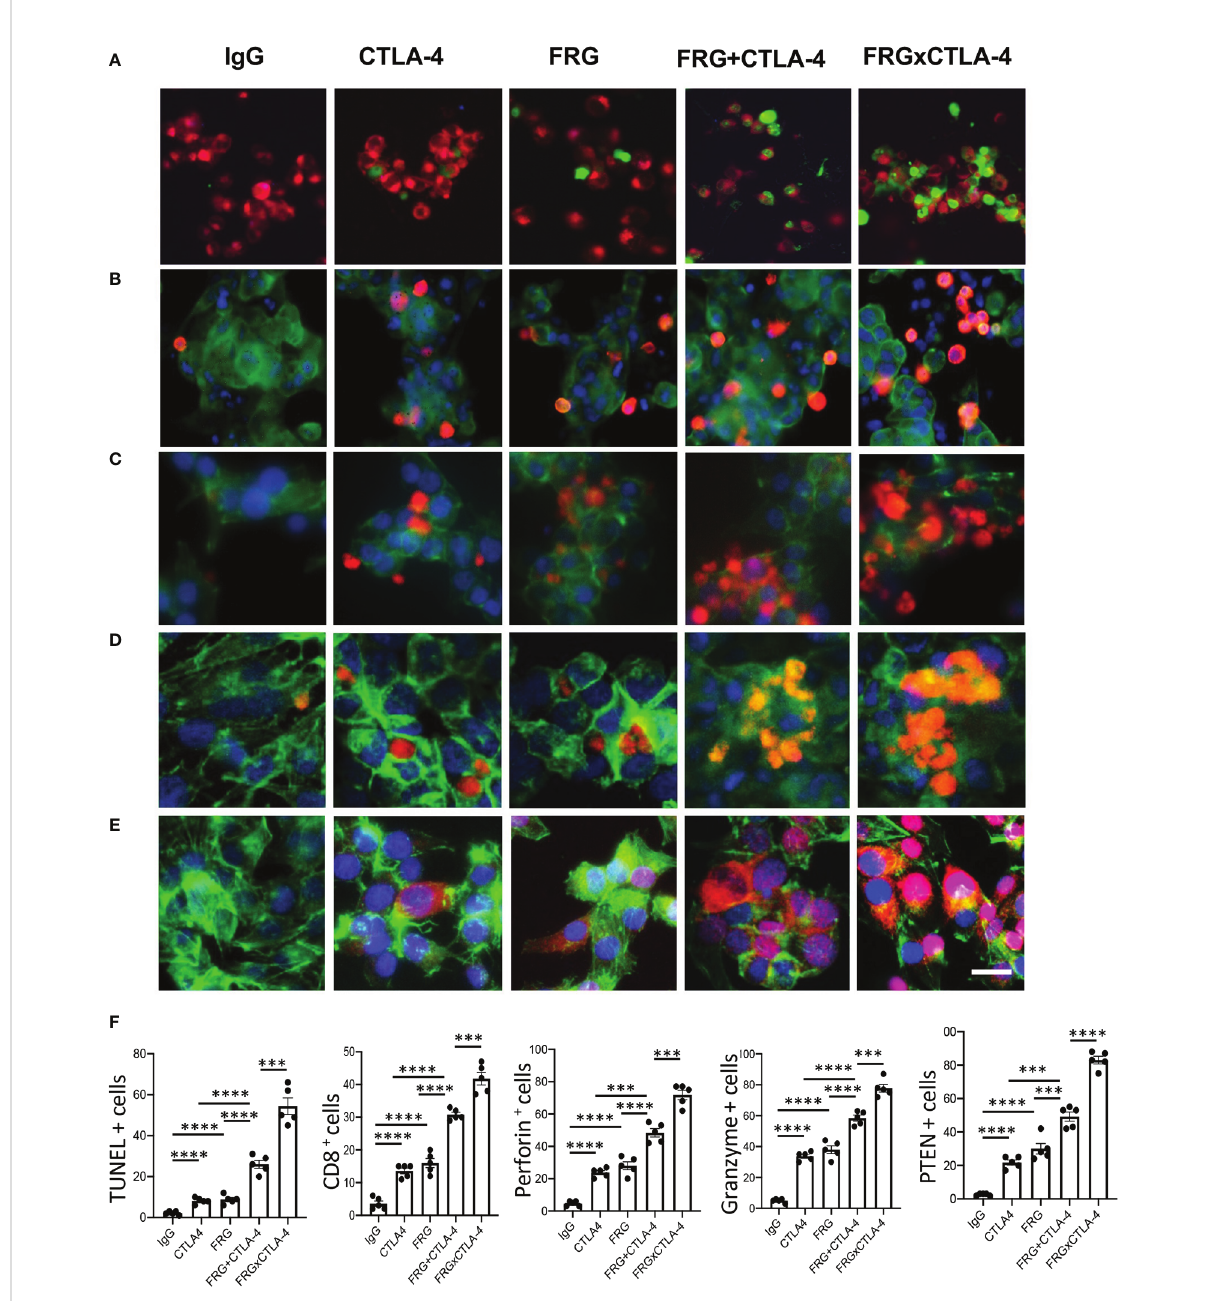
FIGURE 8 Bispeci fi c antibodies that simultaneously target Chi3l1 and CTLA-4 induce synergistic CTL- mediated tumor cell death responses and tumor cell PTEN expression. The antitumor effects of the FRGxCTLA-4 bispeci fi c antibody were evaluated in a co-culture system containing TALL-104 cells and A375 human melanoma cells. TALL-104 cells were activated by pretreatment with anti-CD3 and anti-CD28 (1 µg/ml each and incubated for 2 hrs in 5% CO2 and air at 37°C). The TALL-104 cells were then co-cultured with A357 human melanoma cells for 24 hours. These co-cultures were undertaken in the presence of the following antibodies; isotype control antibody (5 m g/ml), anti-CTLA-4 or anti-Chi3l1 (FRG) alone (5 m g/ ml), or in combination (2.5 m g/ml each), and the bispeci fi c FRGxCTLA-4 antibody (5 m g/ml). (A) Representative demonstration and quantitation of apoptotic tumor cell death using in situ cell detection kit - fl uorescein dUTP. TUNEL (+) cells stain green. (B – D) Representative demonstration and quanti fi cation of TALL-104 cell expression of CD8 (B) , perforin (C) and granzyme (D) . Tumor cells are green and positive staining TALL-104 cells are yellow-orange. (E) Representative demonstration and quanti fi cation of tumor cell PTEN. Tumor cells are green and PTEN is yellow- orange. (F) Quanti fi cation of the evaluations in (A – E) . The % of TUNEL + tumor cells (Column A), % of TALL-104 cells expressing CD8 (column B), perforin (column C) and granzyme (column D) and % of tumor cells expressing PTEN (column E) are illustrated. These evaluations were done using fl uorescent microscopy (x20 of original magni fi cation). In these quanti fi cations, 5 randomly selected fi elds were evaluated. The values in panel F are the mean ± SEM. *** P < 0.001, **** P < 0.0001. Scale bar =10 m m, applies to all subpanels of (A – E)